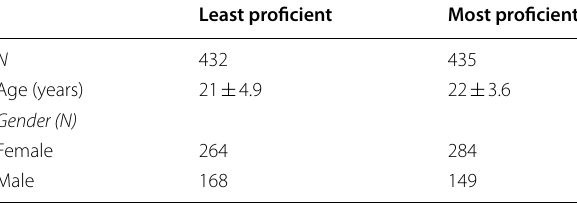
Table 1 Demographic information about performance